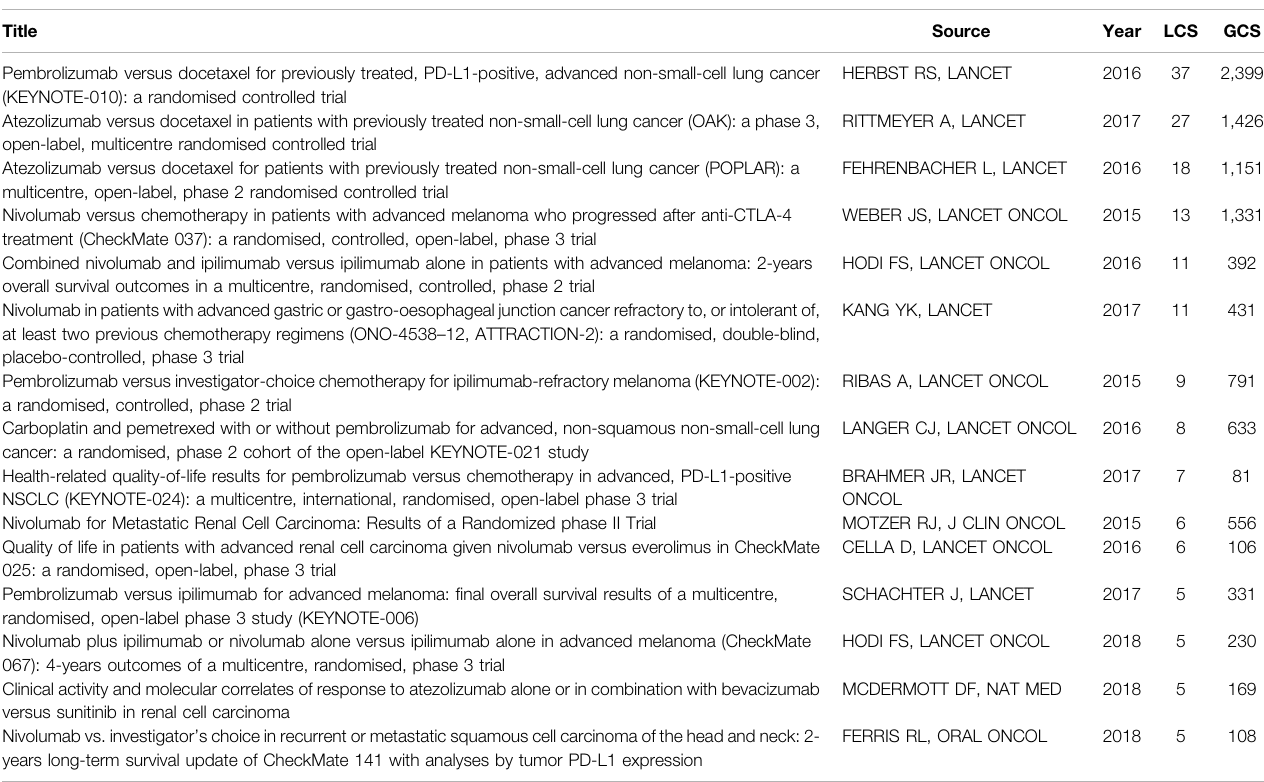
TABLE 4 | Top 15 RCT of anti-PD1/PDL1 sorted by